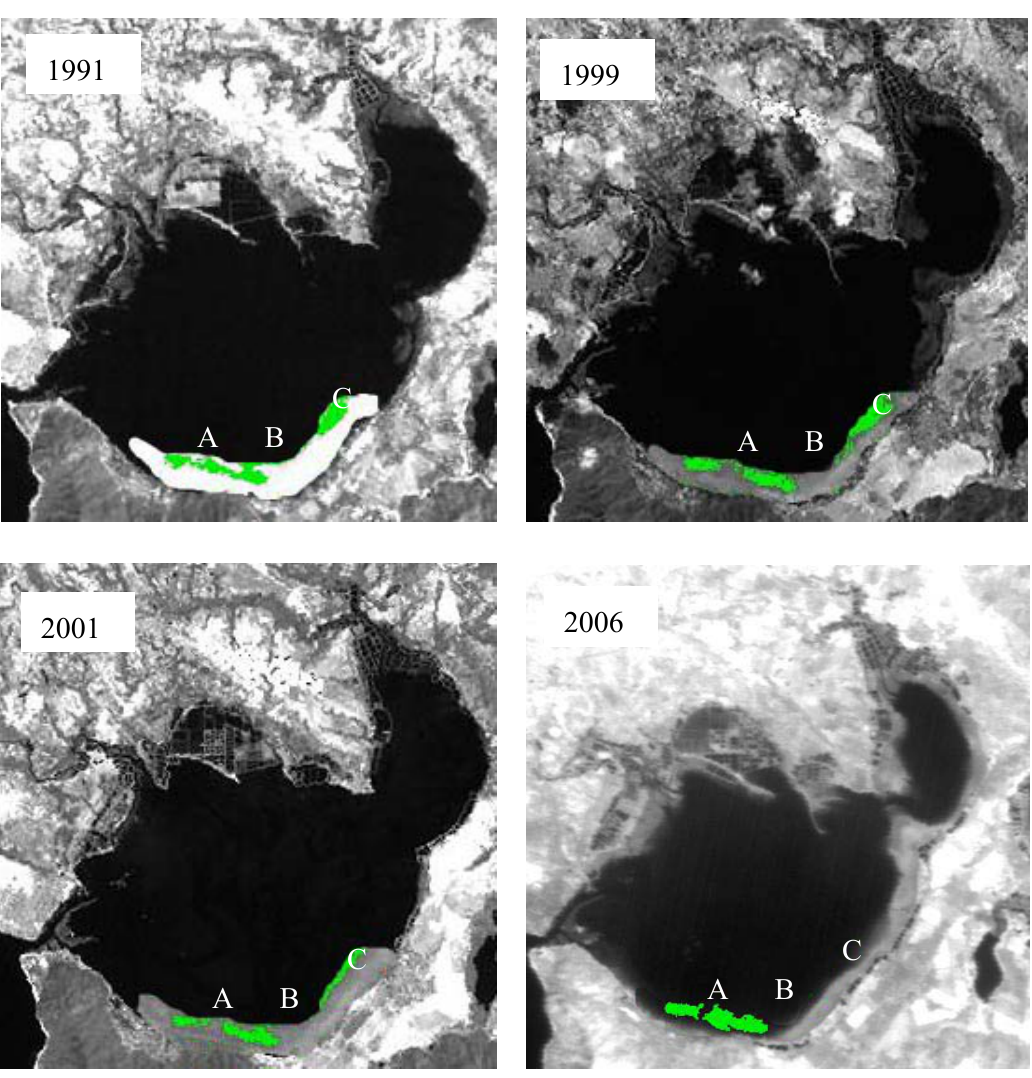
Figure 7. Seagrass distribution change from 1991 to